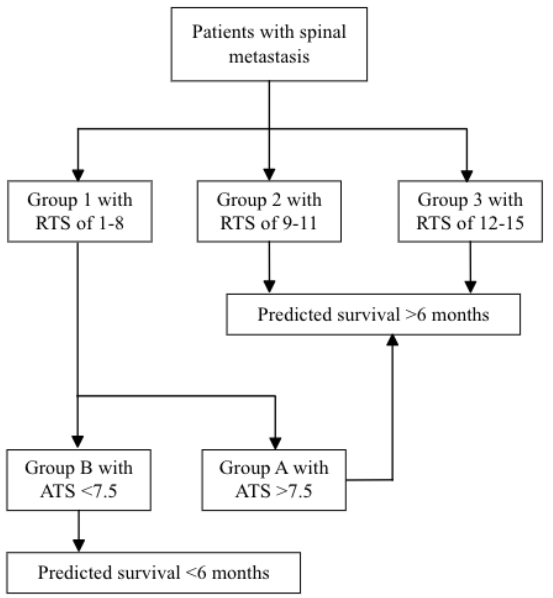
Figure 2. The conceptual of the two-step test. Abbreviation: RTS = revised Tokuhashi score; ATS = adjusted Tokuhashi score. Table 3. Area under receiver operating characteristic curve of different